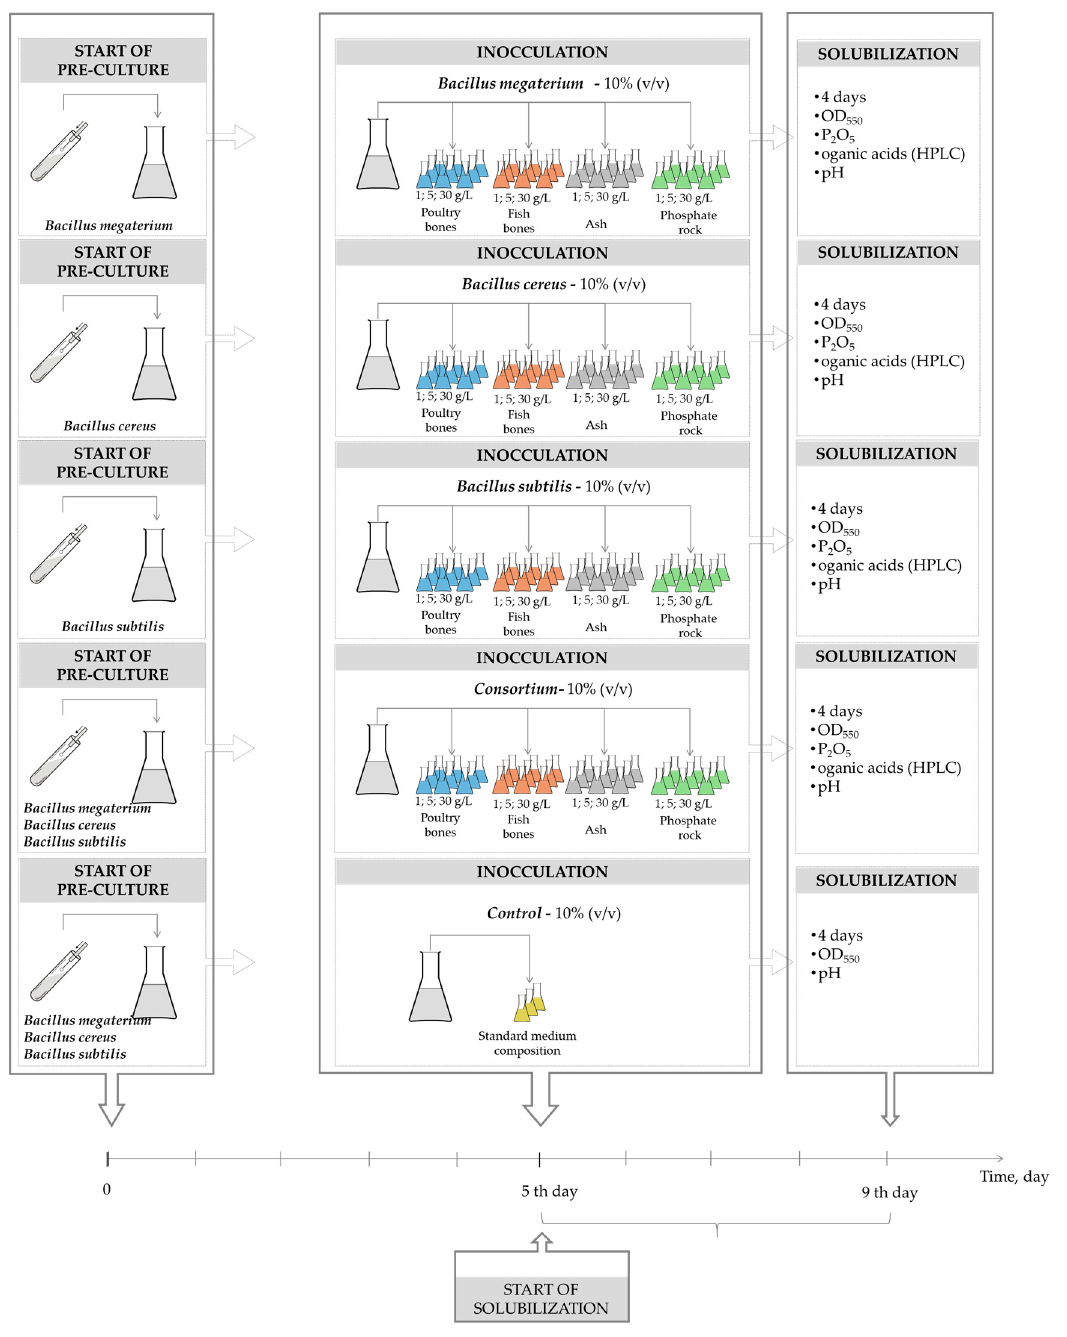
Figure 3. Scheme of performed experiments.